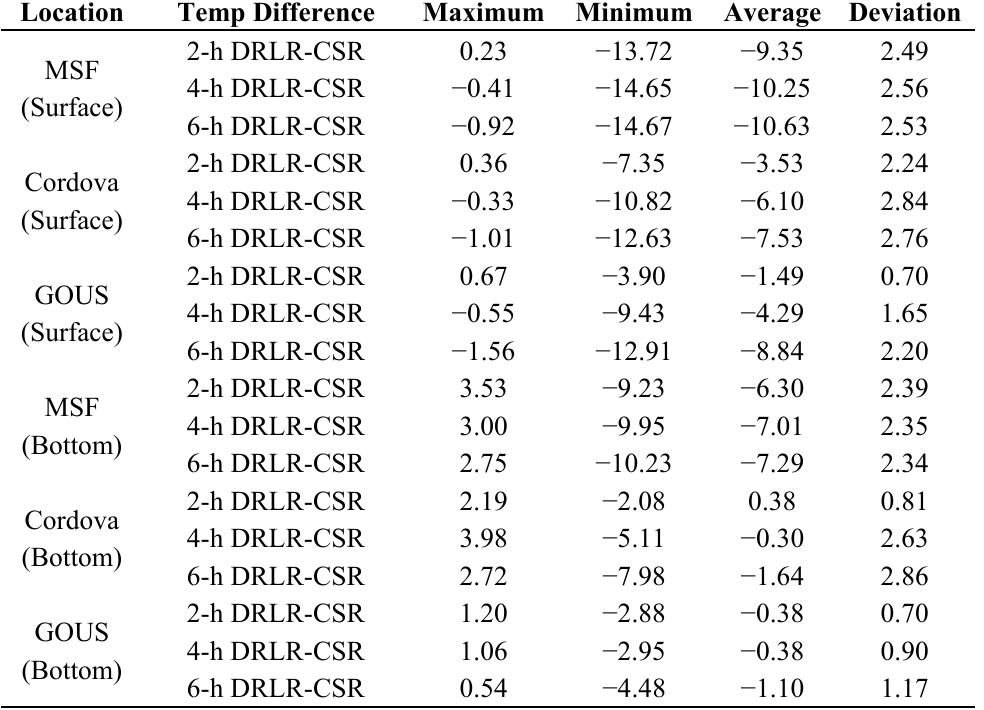
Table 4. Statistical summary of differences (°C) of simulated temperatures between 2-h, 4-h and 6-h DRLRs and CSR only for surface and bottom layers at MSF, Cordova, and